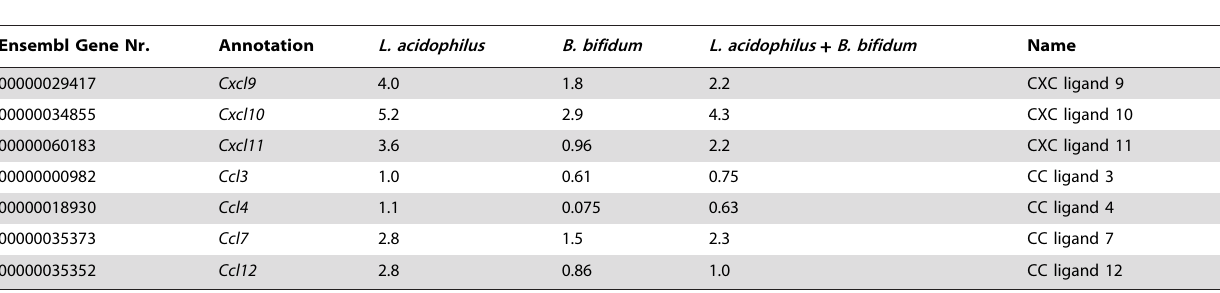
Table 2. Inhibitory Effects of Bifidobacterium bifidum Z9 on the Chemokine Expression in Lactobacillus acidophilus NCFM stimulated Dendritic